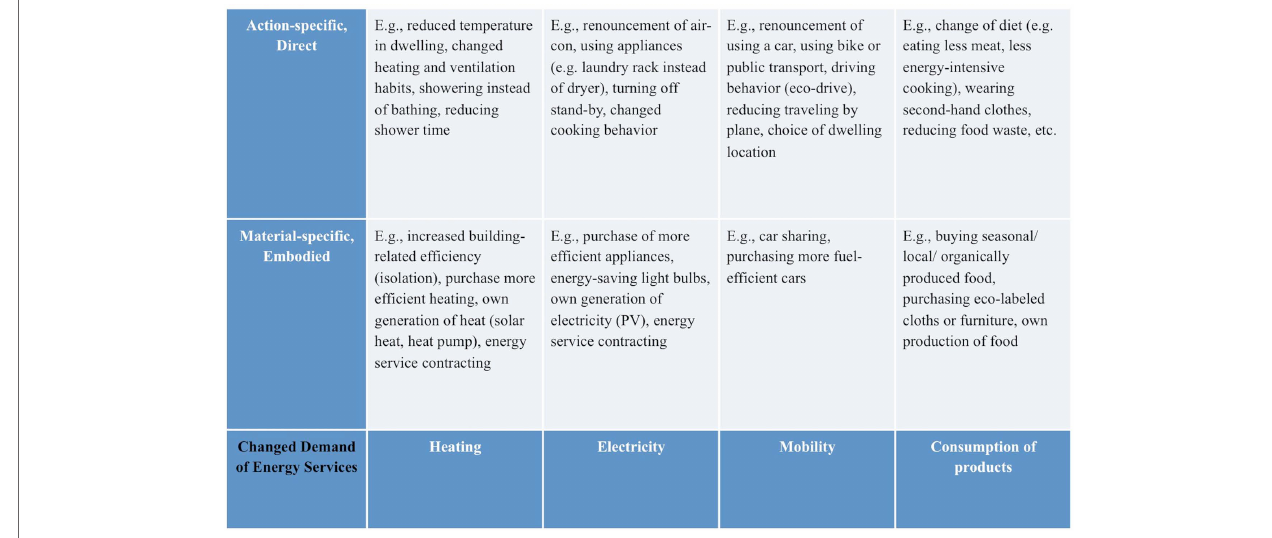
FiGUre 2 | explananda – examples for types of changed eCB